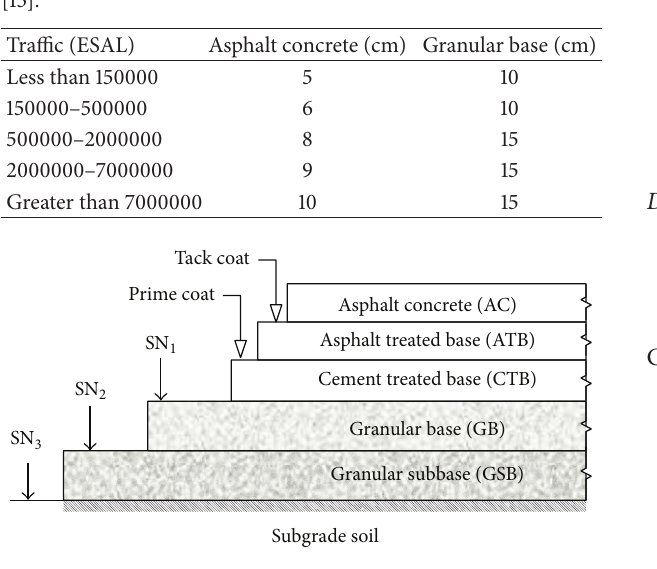
Figure 1: Assumed structure of pavement for